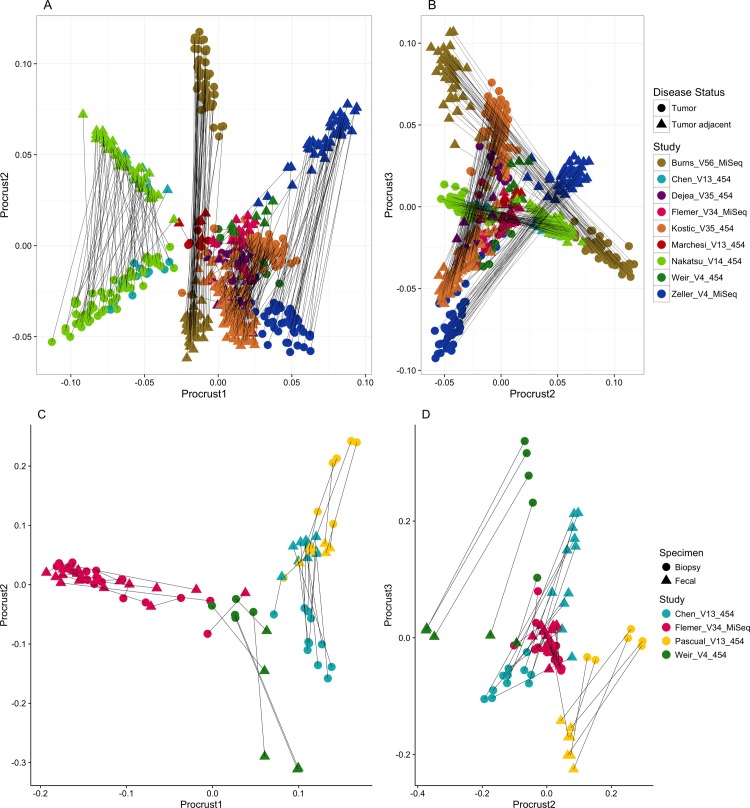
Graphical comparison of CRC tumor:tumor-adjacent tissue (1A and 1B) and paired fecal vs. tumor biopsy (1C and 1D) microbiome configurations using Procustes analysis.In Fig 1, the Procustes analysis showed a moderate [in magnitude] but statistically significant difference between both the paired tumor and tumor-adjacent biopsy (Fig 1A and 1B) microbiome (m2 = 0.68, p < 0.001) as well as paired fecal and CRC tumor tissue samples (Fig 1C and 1D); m2 = 0.65, p < 0.001) from the same case of CRC. Lines connect paired samples. Shapes indicate sample phenotype; colors indicate study cohort.